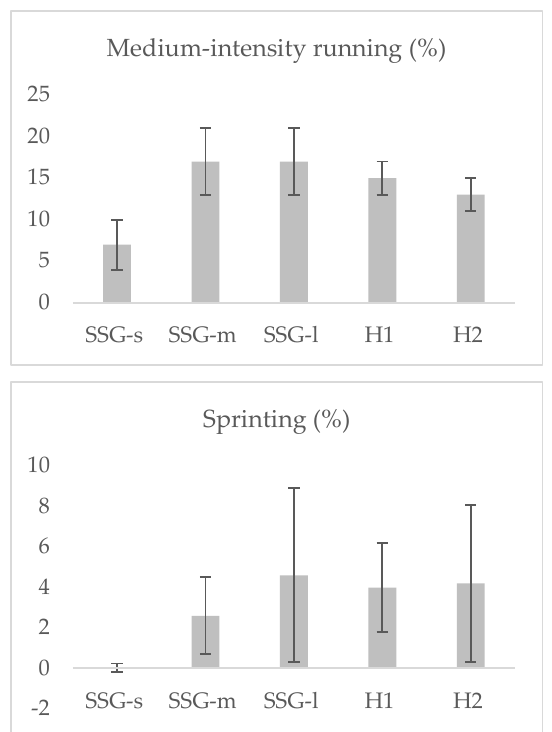
Figure 1. Distances covered to 5 ranges of speed in different SSG and competition match. Walking: